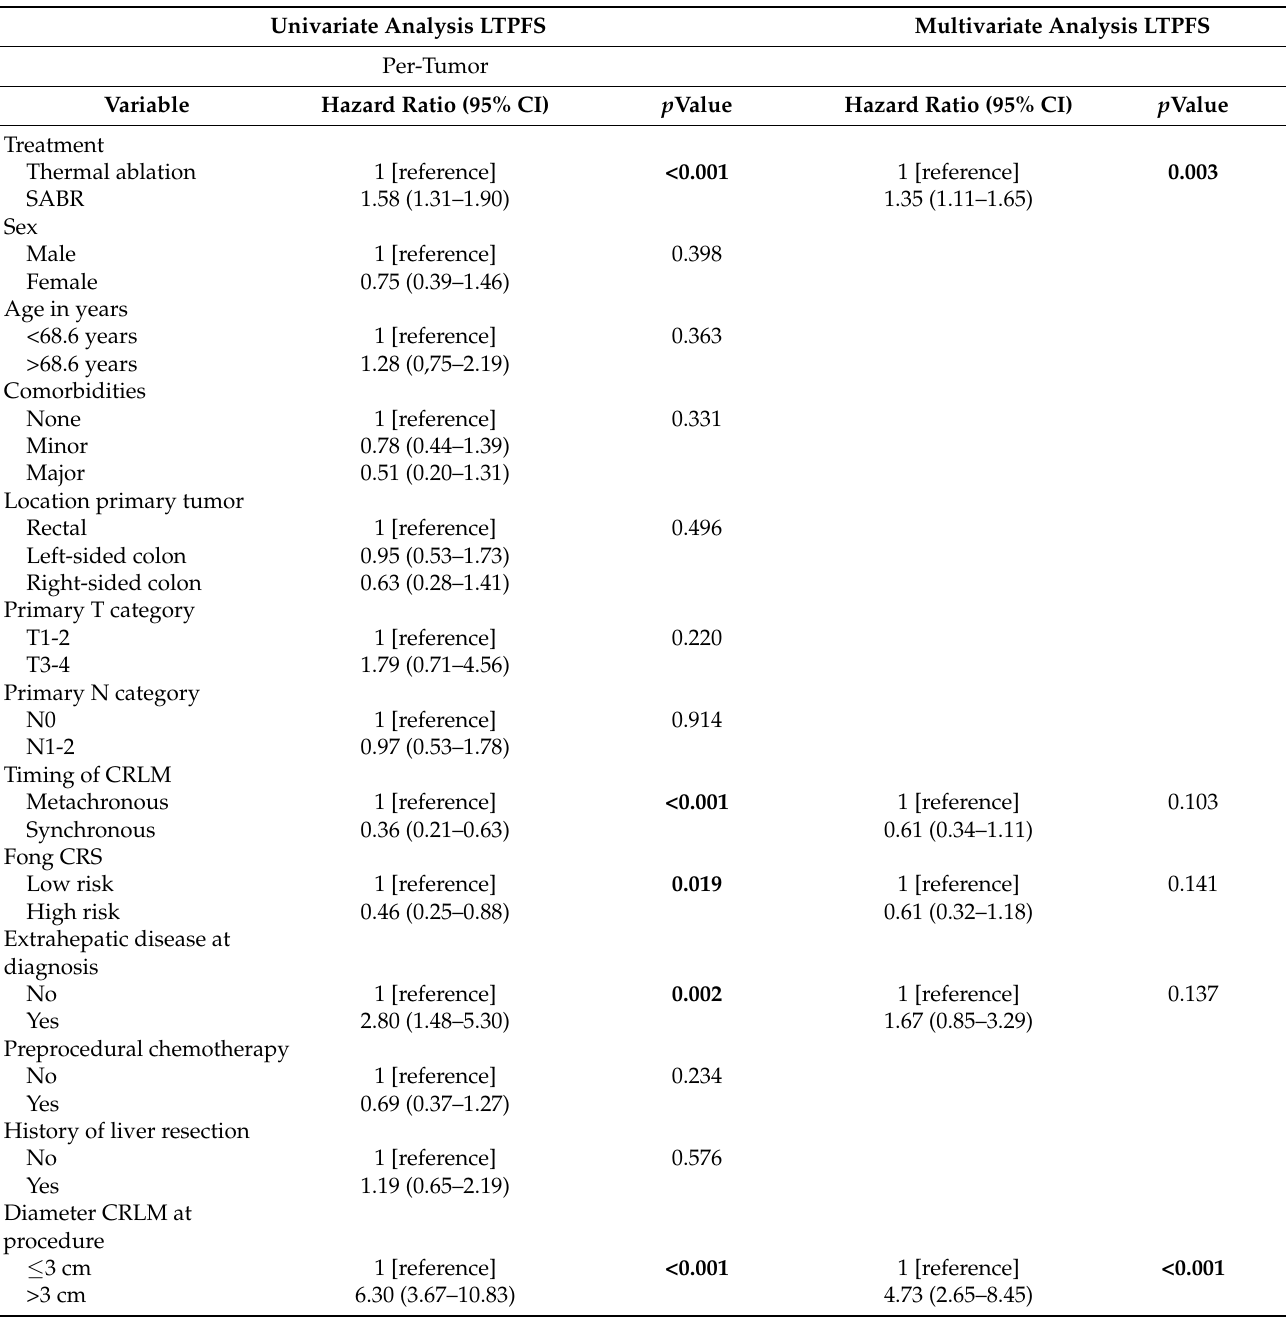
Table 3. Variables associated with LTPFS per-tumor in univariate Cox regression analysis and potential confounders in multivariate Cox regression analysis for LTPFS when comparing SABR to thermal ablation (bold type significant